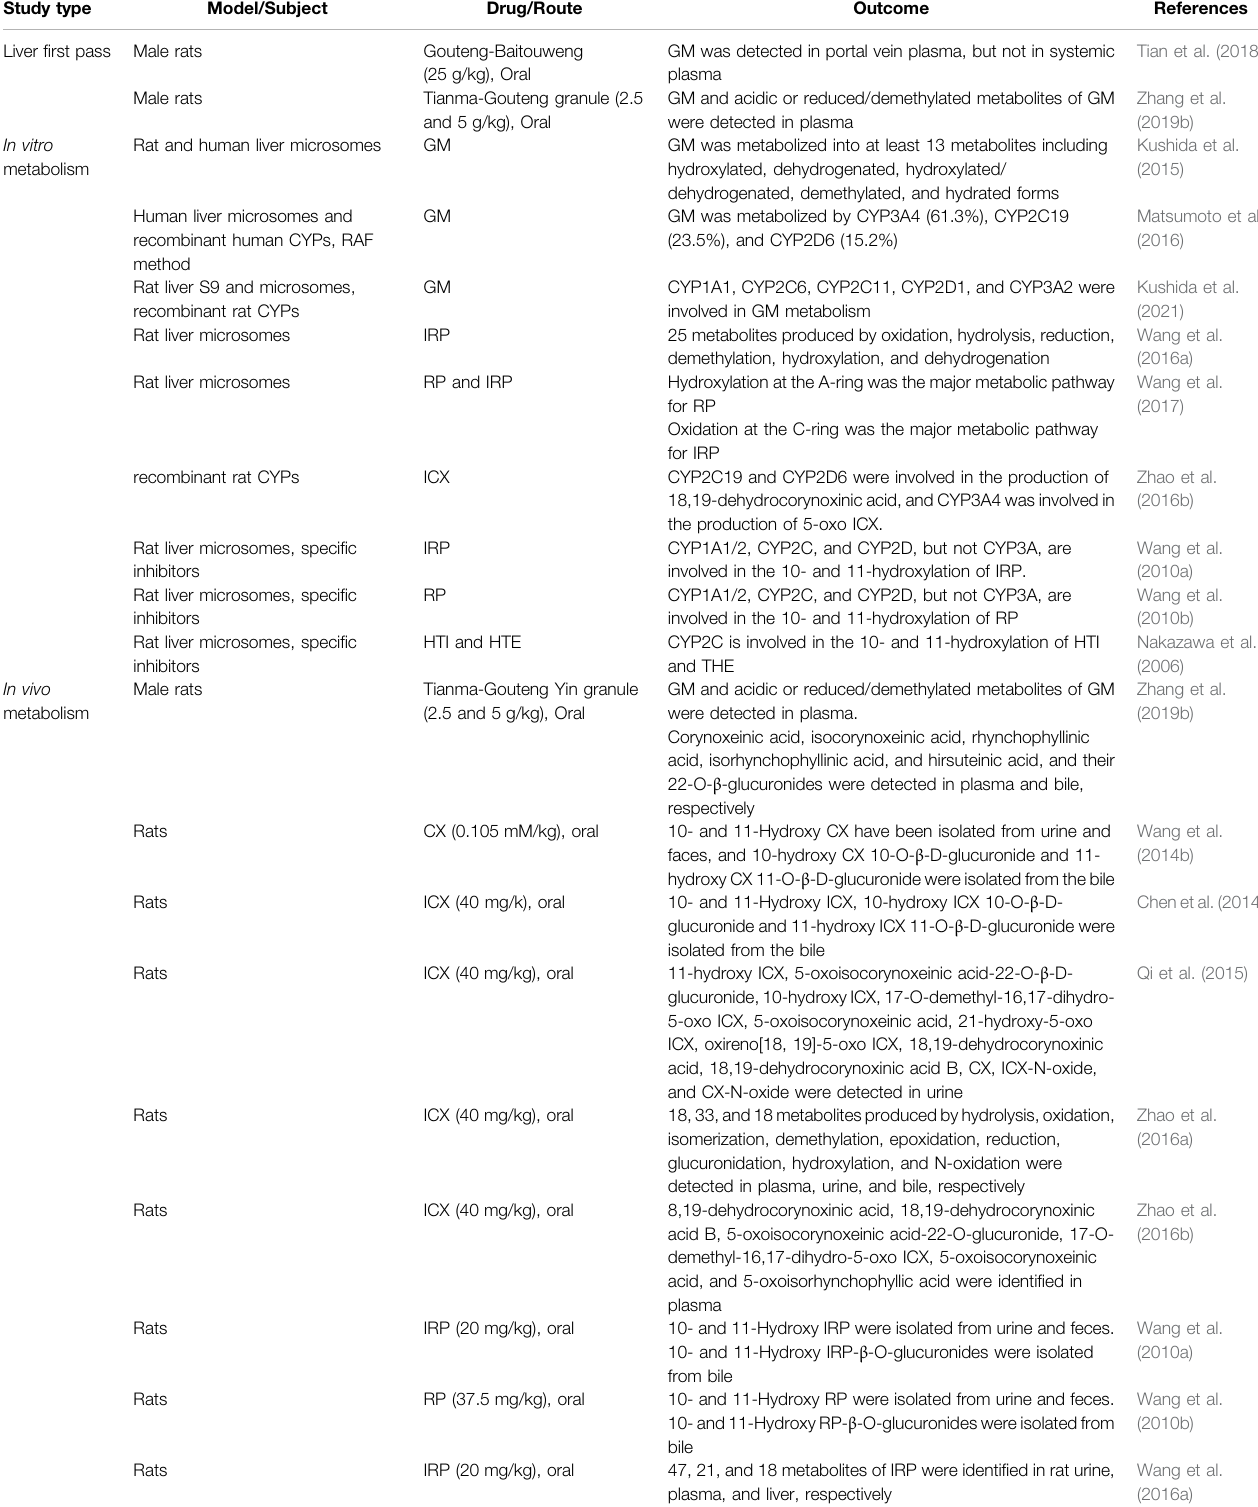
TABLE 3 | Metabolism studies of UH